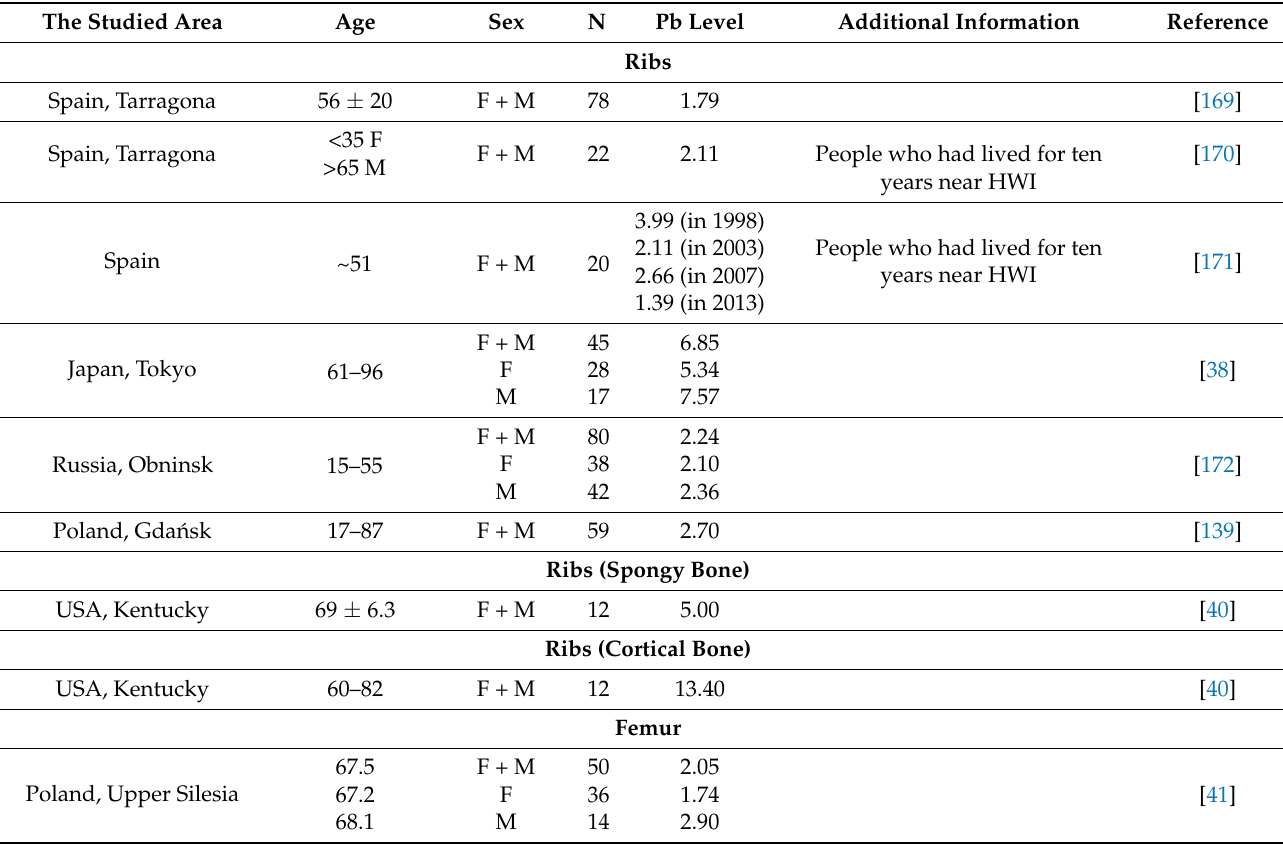
Table 5. Lead levels in human bones in mg kg − 1 dw. (F, female; H, hazardous waste incinerator; M, male; N, number of participants; NS, nonsmoking; S,